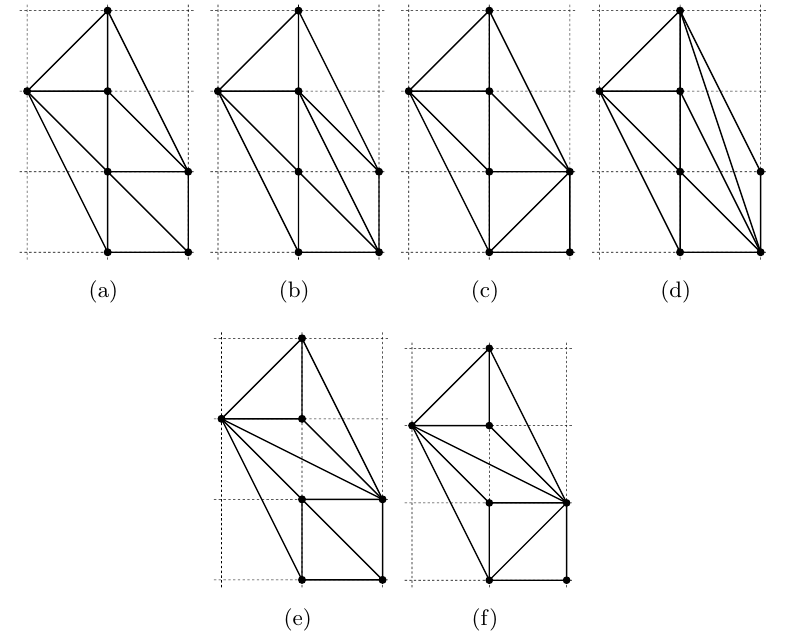
Figure 20 . The 6 crepant singularities of the E 22 ; 1 2 singularity. The (cid:12)rst four, (a)-(d) admit a vertical reduction, corresponding to chambers of the SU(3) 1 N f = 1 gauge